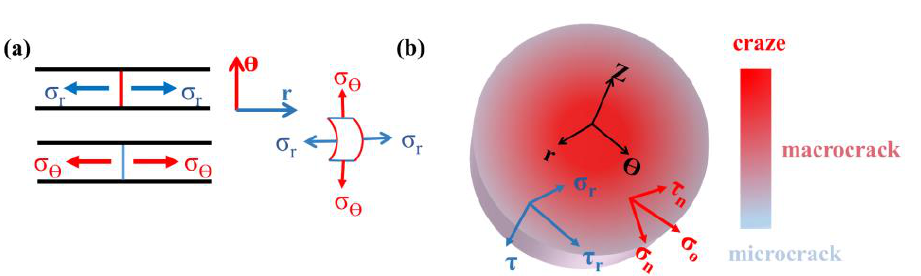
Figure 10. ( a ) Schematic diagram of radial stress and circumferential stress, and ( b ) The schematic diagram of the decomposition of radial and circumferential stresses and the degree of damage to the